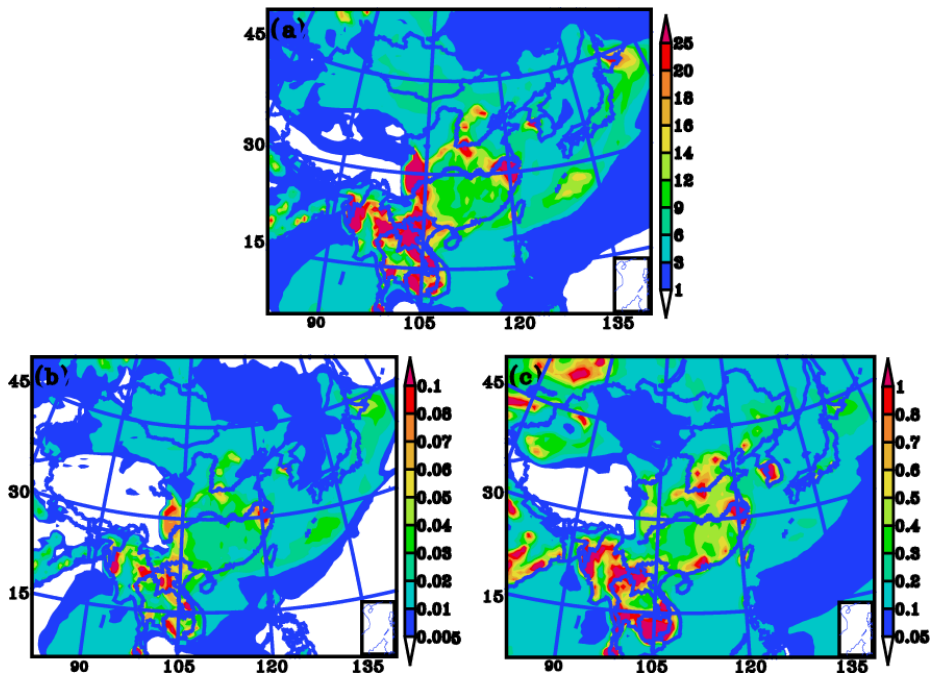
Figure 11. (a) Ensemble spread of C f model-level 1 at 00:00UT on 1 March 2010, when β = 70.